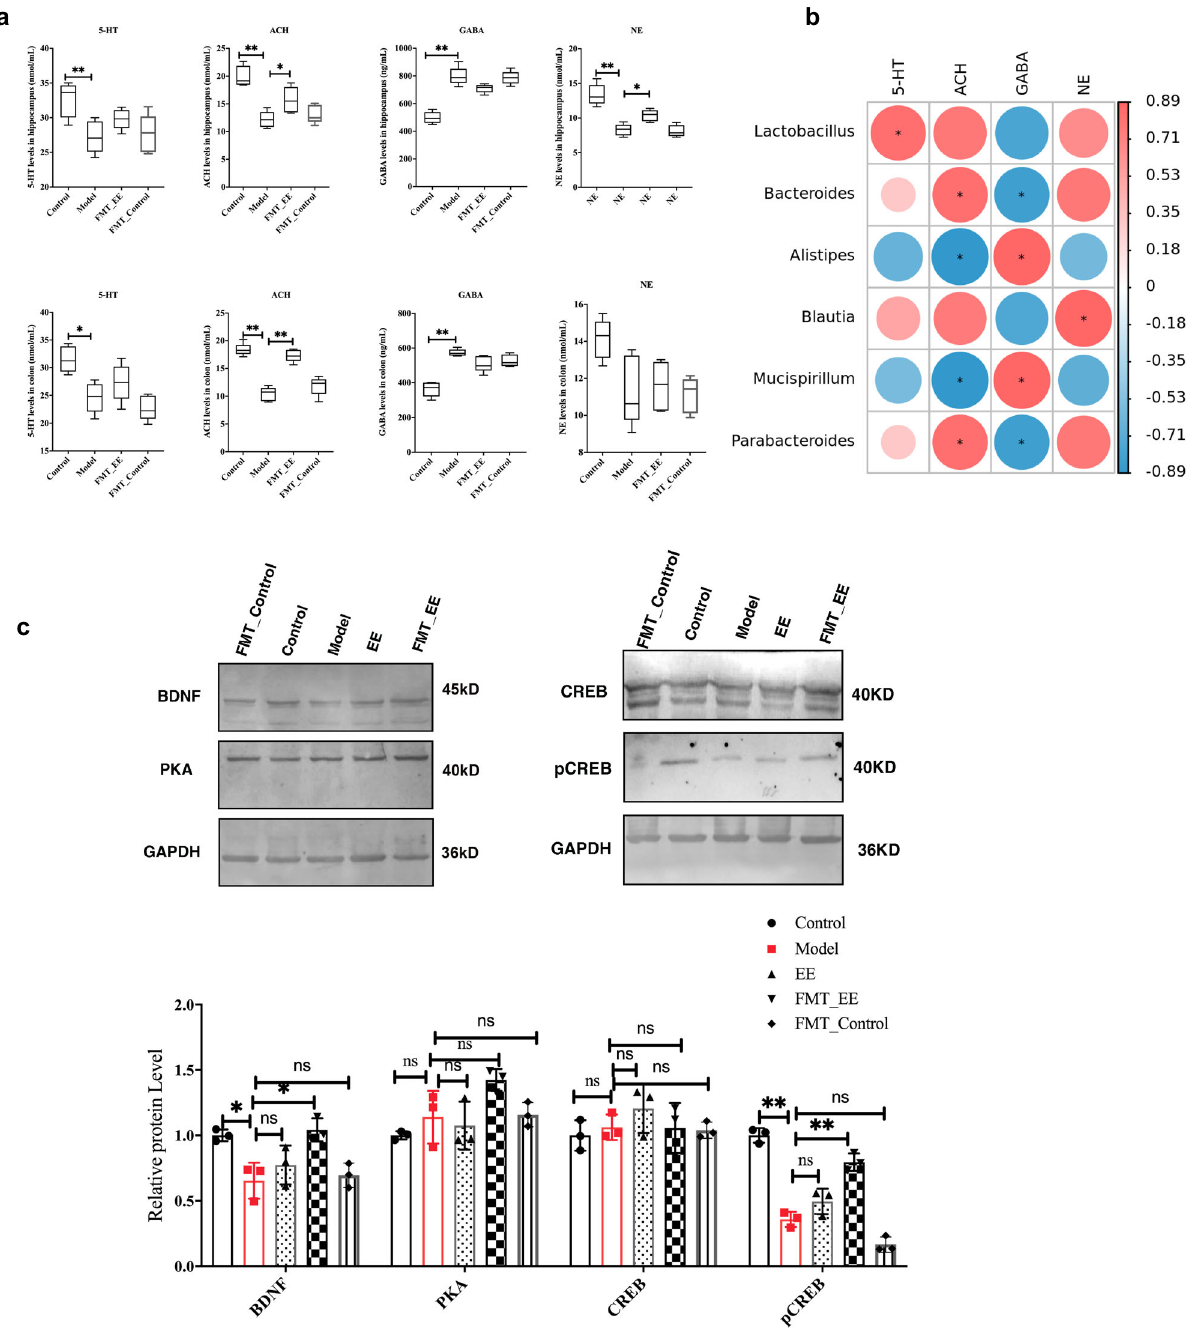
Fig. 9 FMT from EE-fed mice affected the neurotransmitters and their associated microbiome and regulated the PKA/CREB/BDNF signaling. a The levels of neurotransmitters in hippocampus and colon in FMT mice. (Values are expressed as the mean ± SD ( n = 5). Statistical analyses were conducted using the one-way ANOVA followed by Tukey ’ s post hoc test, * p < 0.05, ** p < 0.01). b Spearman ’ s correlation analysis among neurotransmitters and gut microbiota was performed by data of the Model group and FMT_EE group. c The relative protein levels in different groups. (Values are expressed as the mean ± SD ( n = 3). Statistical analyses were conducted using the one-way ANOVA followed by Tukey ’ s post hoc test, * p < 0.05, ** p < 0.01; the samples derive from the same experiment or parallel experiments and that blot was processed in